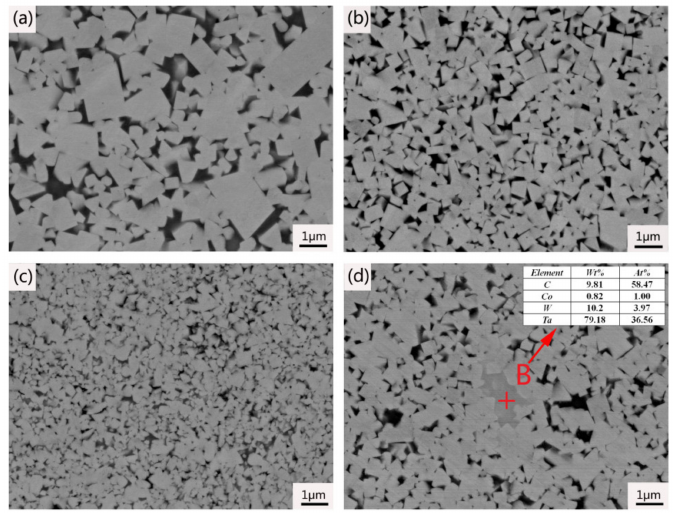
Figure 4. SEM images showing the microstructures of WC–10 wt. % Co sintered cemented carbides. ( a ) WC–10Co; ( b ) WC–10Co–0.8Cr 3 C 2 ; ( c ) WC–10Co–0.8VC; ( d )